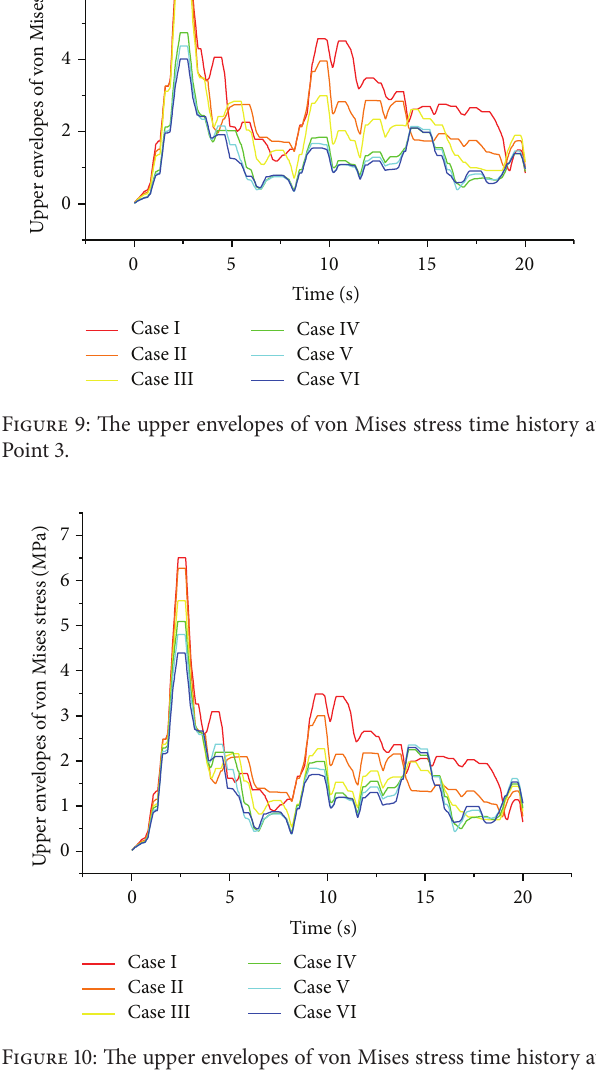
Figure 10: The upper envelopes of von Mises stress time history at Point